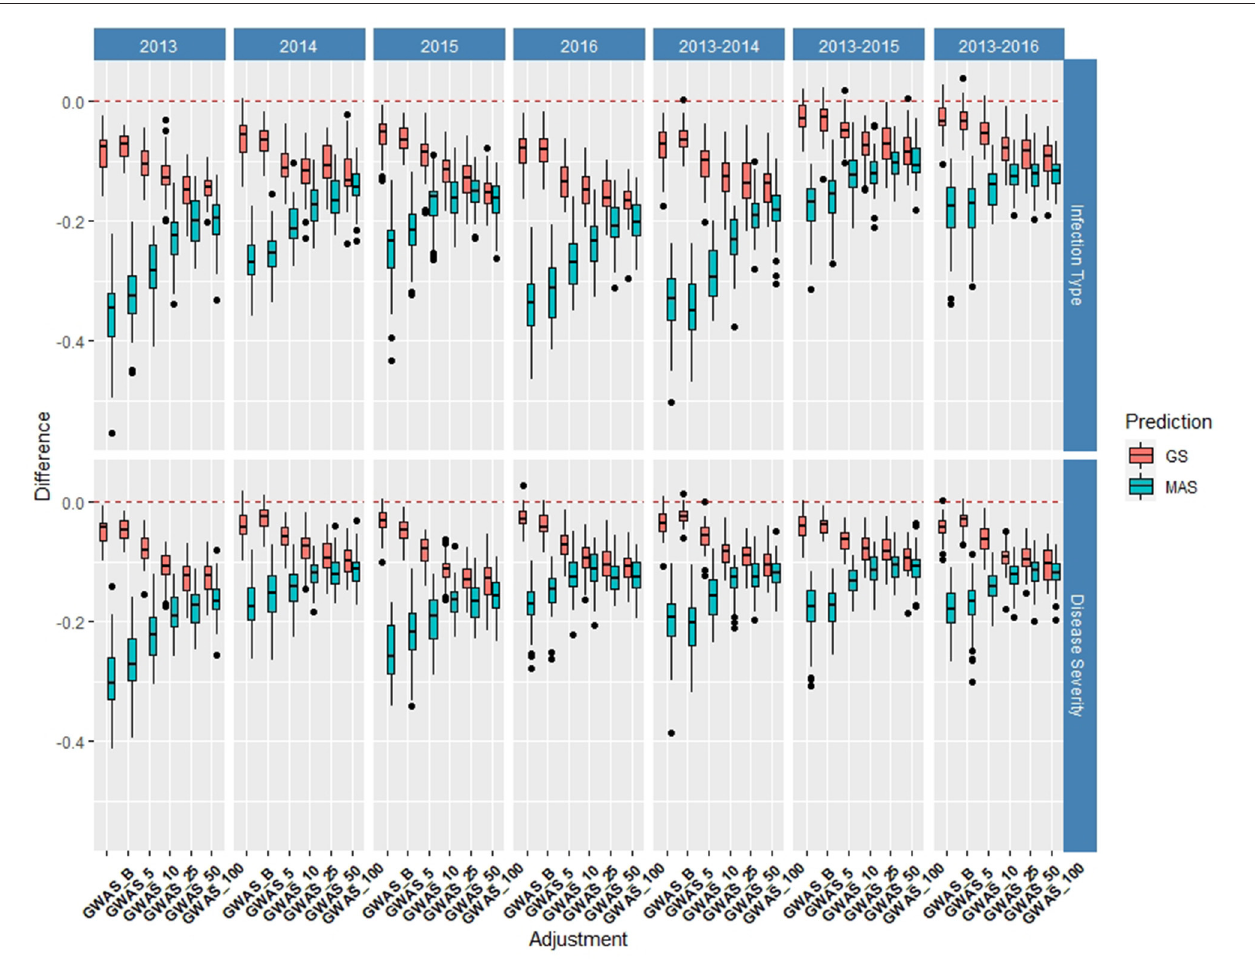
FIGURE 7 | Difference in prediction accuracy from the base rrBLUP model for de novo GWAS markers in GS and MAS using cross-validations in the diversity panel (DP) lines phenotyped from 2013 to 2016. Adjustments: GWAS_B, GWAS-GS with Bonferonni significant markers; GWAS_5, GWAS-GS with the top five significant markers; GWAS_10, GWAS-GS with the top 10 significant markers; GWAS_25, GWAS-GS with the top 25 significant markers; GWAS_50, GWAS-GS with the top 50 significant markers; GWAS_100, GWAS-GS with the top 100 significant